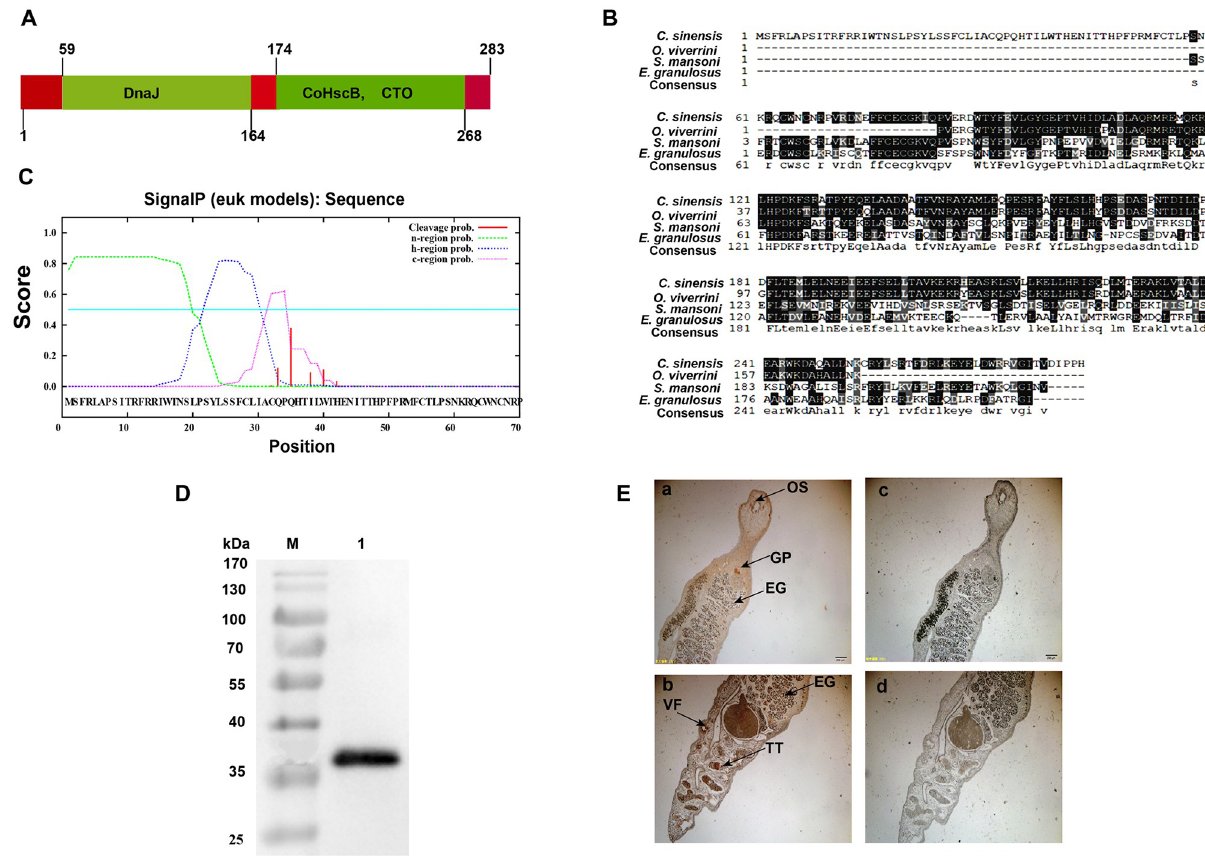
Fig 1. Identification, characterization, and immunogenicity of Clonorchis sinensis HscB. (A) Secondary structure of CsHscB including three domains: DnaJ, Co-chaperone HscB (CoHscB), and C-terminal oligomerisation (CTO). (B) Multiple protein sequences alignment of CsHscB among different species of the helminthes. ( C ) Signal peptide identification of CsHscB using SignalP server 3.0. (D) Western-blot analysis of purified rCsHscB using an anti-His antibody. (E) Expression and distribution of rCsHscB in the C . sinensis adult worms using IHC. a~b:rCsHscB on the worm bodies were detected using the primary antibody of rCsHscB; c~d: rCsHscB on the worm bodies were detected using IgG isotype as the primary antibody for controls. Arrows indicate the expression of rCsHscB mainly on the oral sucker (OS), vitelline follicles (VF), genital pore (GP), testis (TT), and eggs (EG). Scale bars, 20 μ